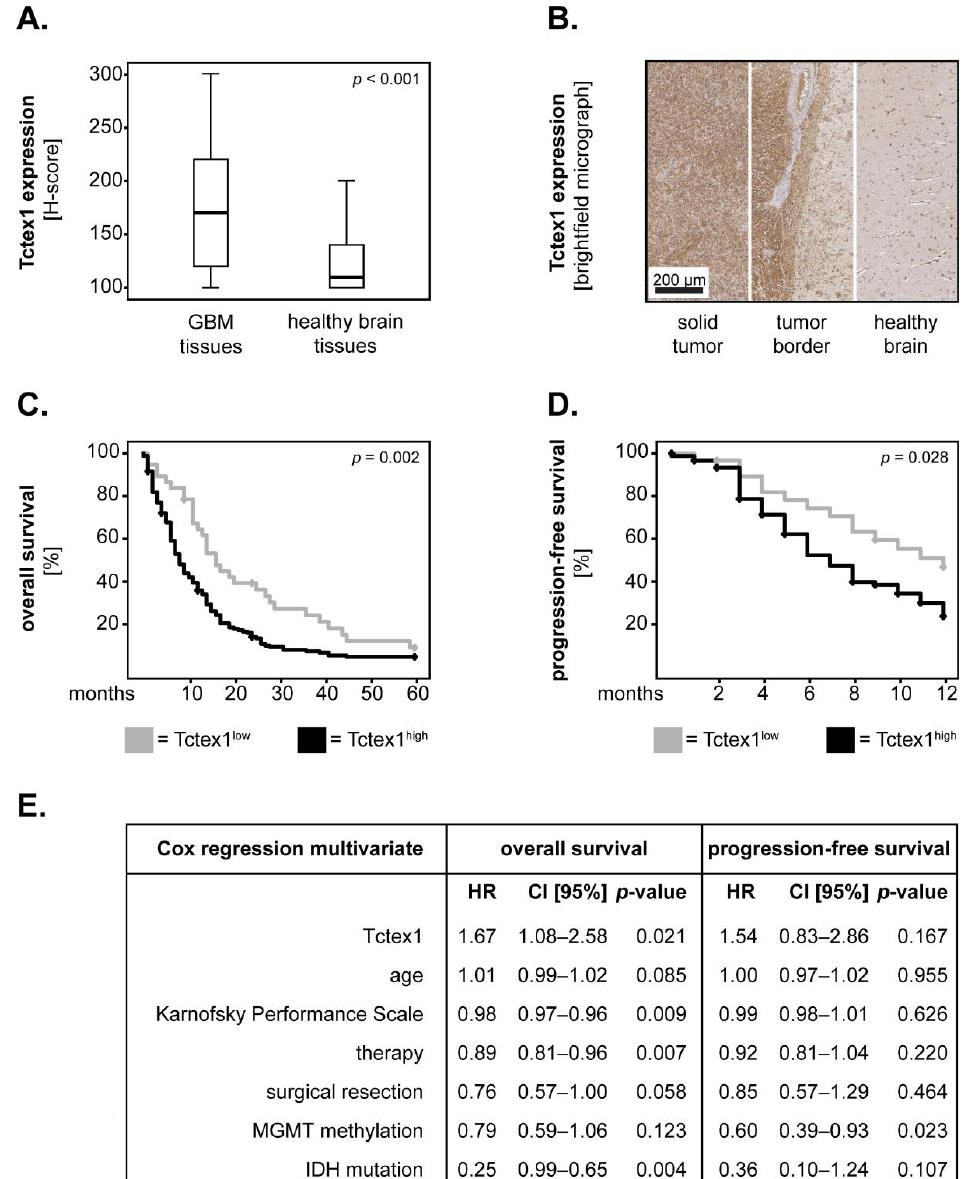
Figure 2. Tctex1 in GBM patients. ( A ) Tctex1 expression in matched pairs of GBM tissues and adjacent, tumor-free brain tissues ( n = 42). The medians are shown as black lines and the percentiles (25th and 75th) as vertical boxes with error bars. Statistical analysis was performed with the Wilcoxon test. ( B ) Representative micrographs showing the expression of Tctex1 in the solid tumor area (left panel), tumor border area (middle panel) and adjacent, tumor-free tissue area (right panel), respectively. Kaplan–Meier curves for the ( C ) 5-year overall survival and ( D ) 1-year progression-free survival of GBM patients with high versus low levels of Tctex1. The log-rank test was used for statistical analysis, and the p -values are indicated in the upper-right corner of each plot. ( E ) Multivariate Cox regression analysis model for the overall and progression-free survival of patients with high versus low levels of Tctex1. HR: hazard ratio; CI [95%]: 95% confidence interval.